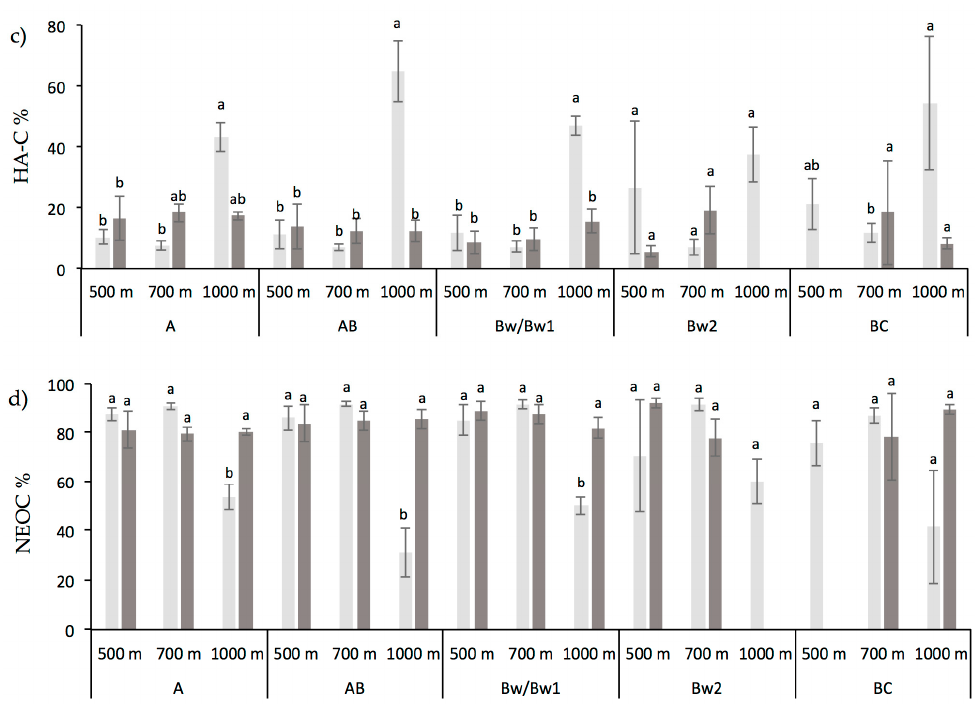
Figure 2. Percentage distribution of the soil organic carbon as ( a ) water-extractable organic carbon (WEOC), ( b ) fulvic acid carbon (FA-C), ( c ) humic acid carbon (HA-C) and ( d ) non-extractable organic carbon (NEOC) for the soils under broadleaf (light bars) and pine (dark bars) forests at 500, 700 and 1000 m a.s.l., Mount Cucco massif (Central Apennines, Italy). Error bars are the standard errors ( n = 3). For each soil parameter and horizon, di ff erent letters indicate significant di ff erences among vegetation types and altitudes according to Tukey’s test ( p < 0.05).